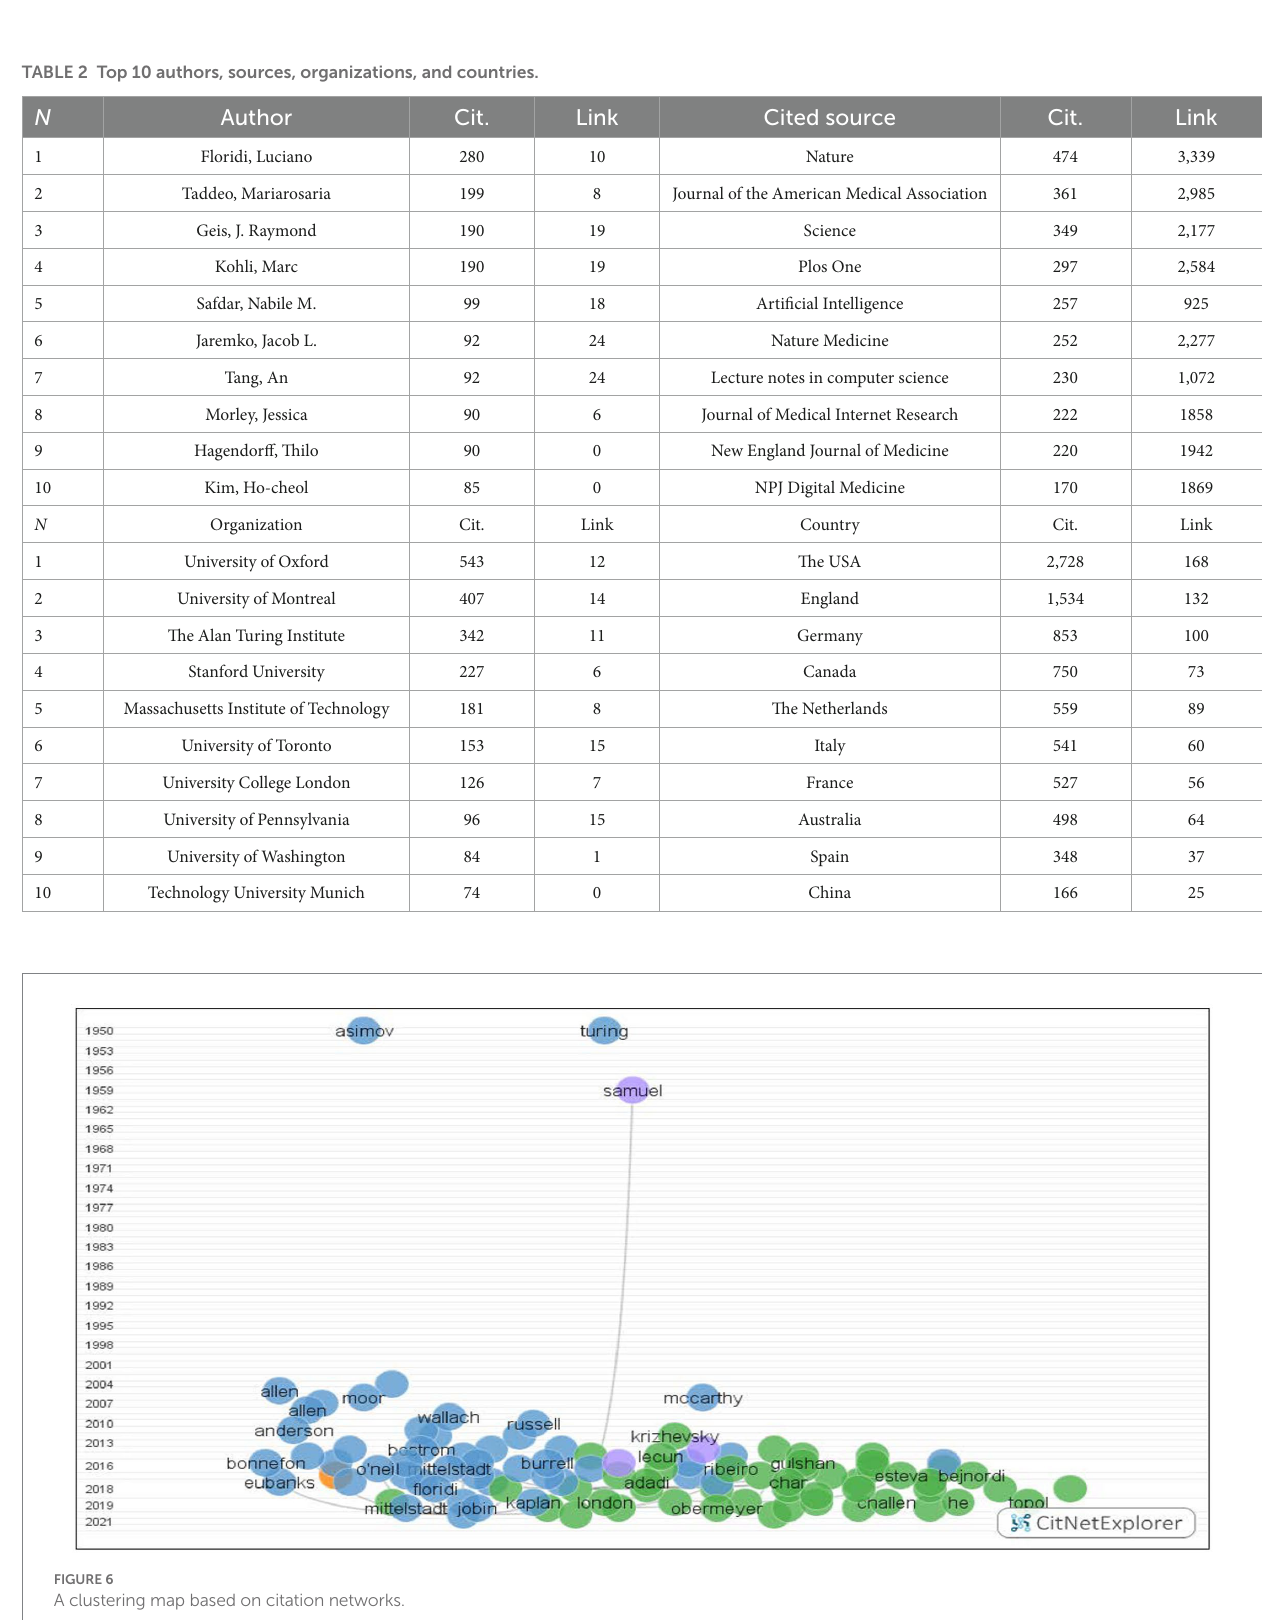
and 2 publications with higher than 15 citation scores; Group 4 included 13 publications, 15 citation links, and no publications with higher than 15 citation scores. Considering the large number of publications and citation links, we, therefore, focused our analyses on